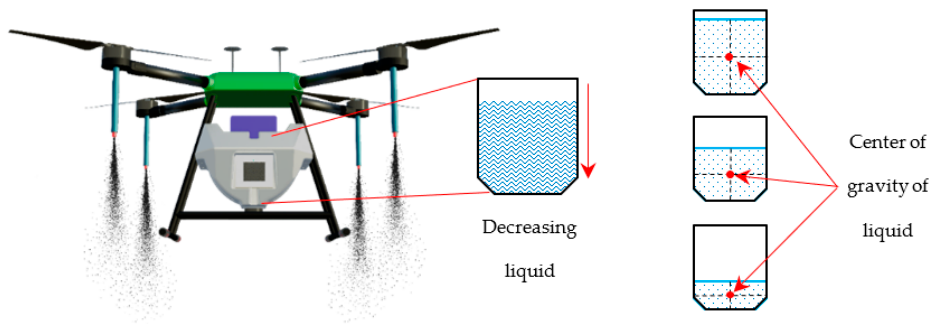
Figure 2. Agricultural sprayer UAV (quadrotor).